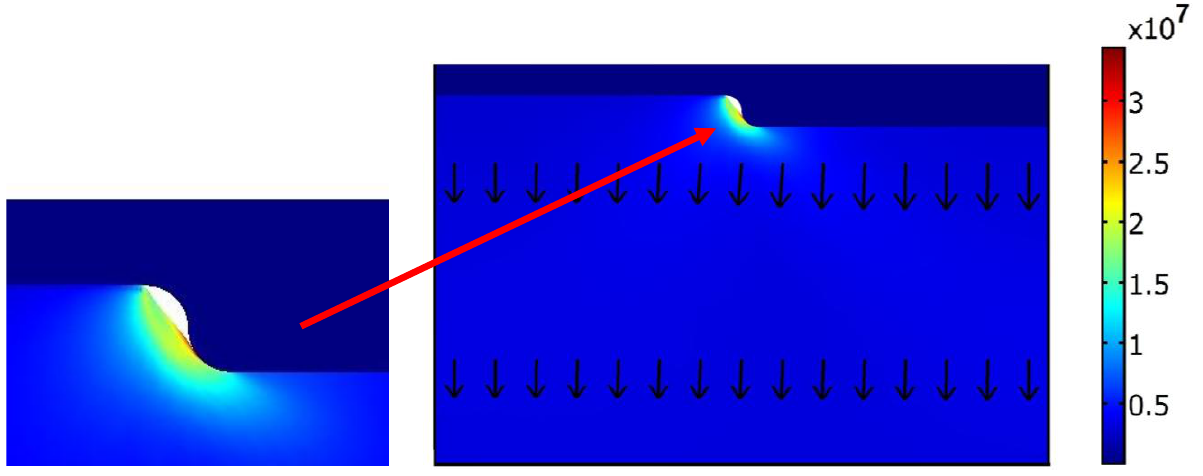
Figure 9. Von Mises stress distribution in the deformed polycarbonate (in Pa) and total displacements (in meter) represented by arrows after imprint step.